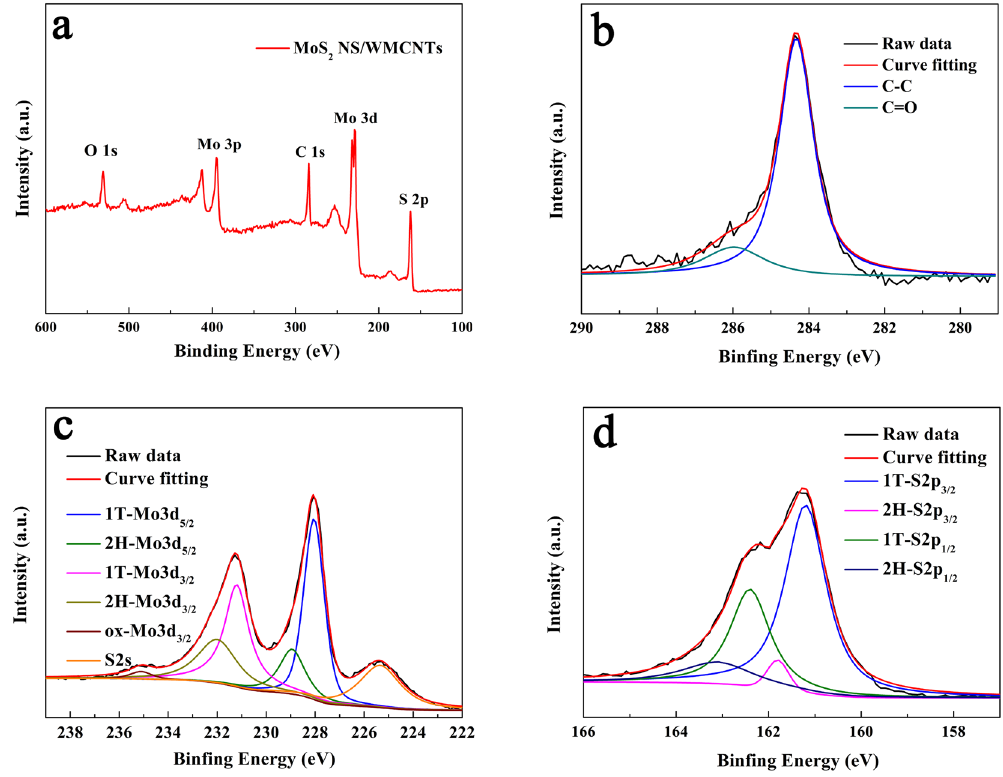
Figure 3. ( a ) XPS survey spectra and ( b – d ) high-resolution XPS spectra of the MoS 2 NS/MWCNT